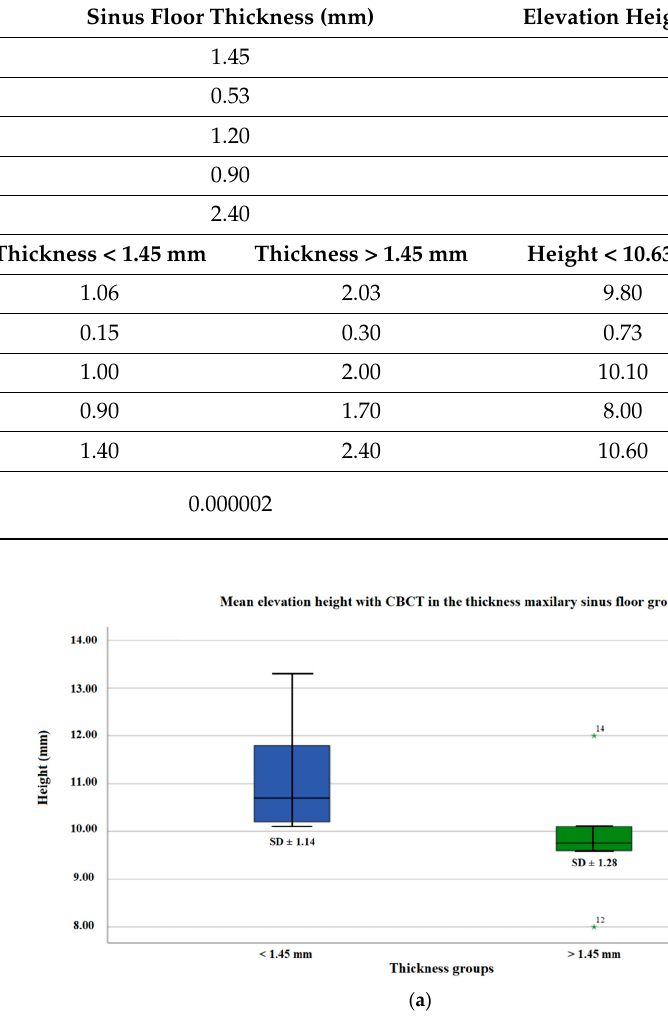
Table 2. Shows a comparison between the thickness of the sinus floor ( p = 0.000002) and the elevation height measured with CBCT ( p = 0.0014). There was a significant difference of 0.97 mm between sinus floor thickness groups. There were significant differences of 2.08 mm in the elevation height.